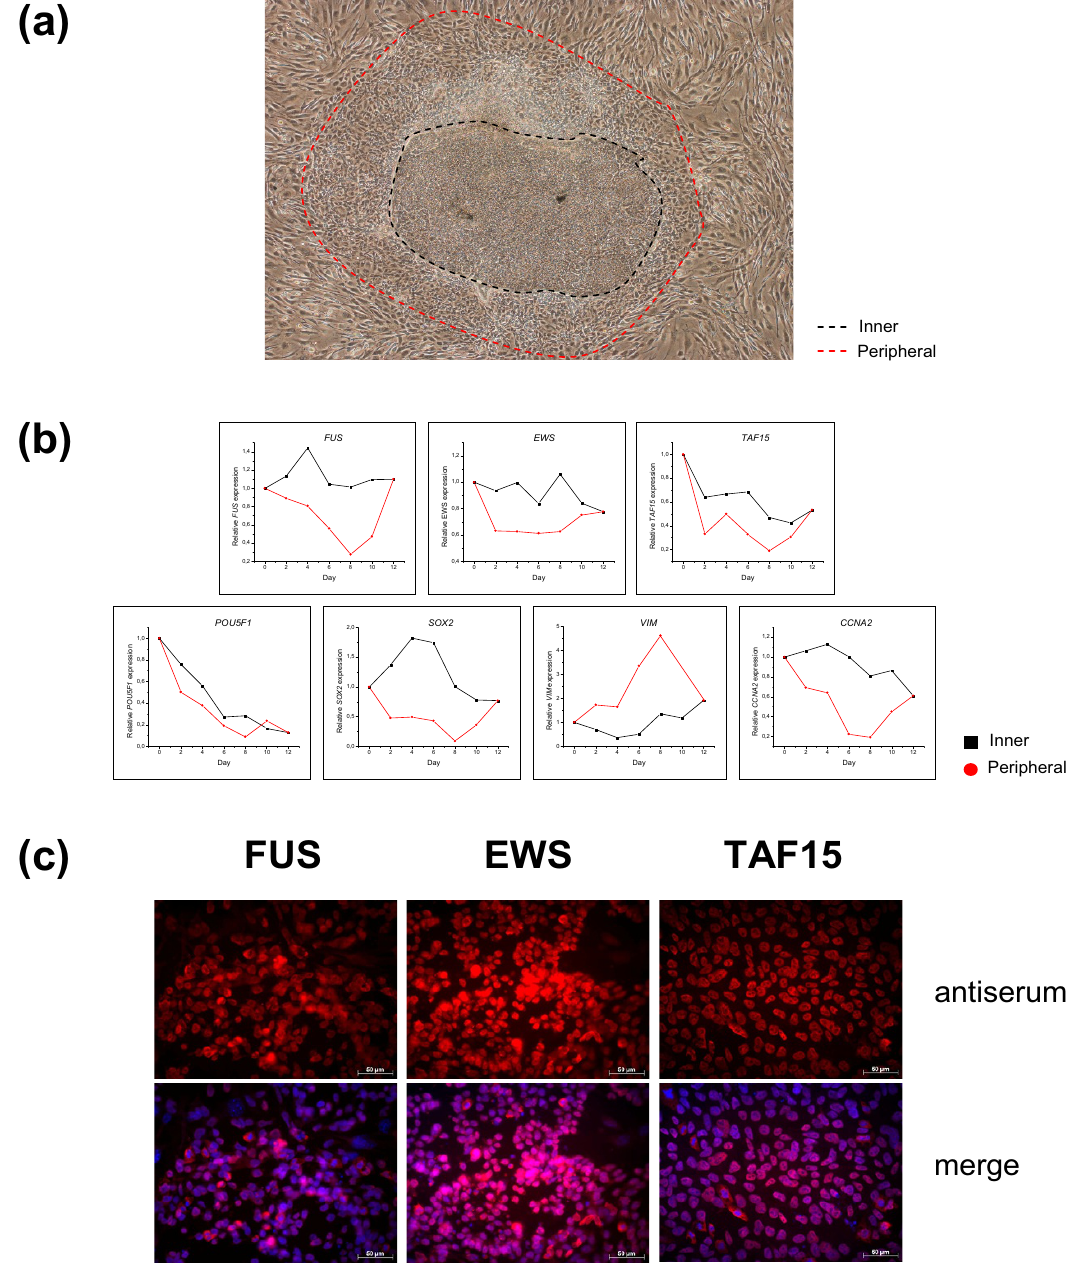
Figure 7 FET gene expression is attenuated in differentiating human embryonic stem cells . (a) A colony of spontaneously differentiating hESCs. Inner and peripheral parts of the colonies were harvested based on cell morphology. (b) Relative expres- sion of selected mRNAs in samples from inner or peripheral parts of colonies analyzed by quantitative real-time PCR with ACTB as endogenous control. POU5F1 – pluripotency marker, SOX2 – ectodermal marker, VIM – mesodermal marker, CCNA2 – proliferation marker. The day 12 measurement consists of one sample taken from inseparable, mixed cell populations. (c) Undifferentiated hESCs show positive FET protein staining. Cells were stained with primary antibodies for FET proteins and visualized with Cy3-conjugated secondary antibodies (red). The merge images additionally show DAPI staining of nuclei